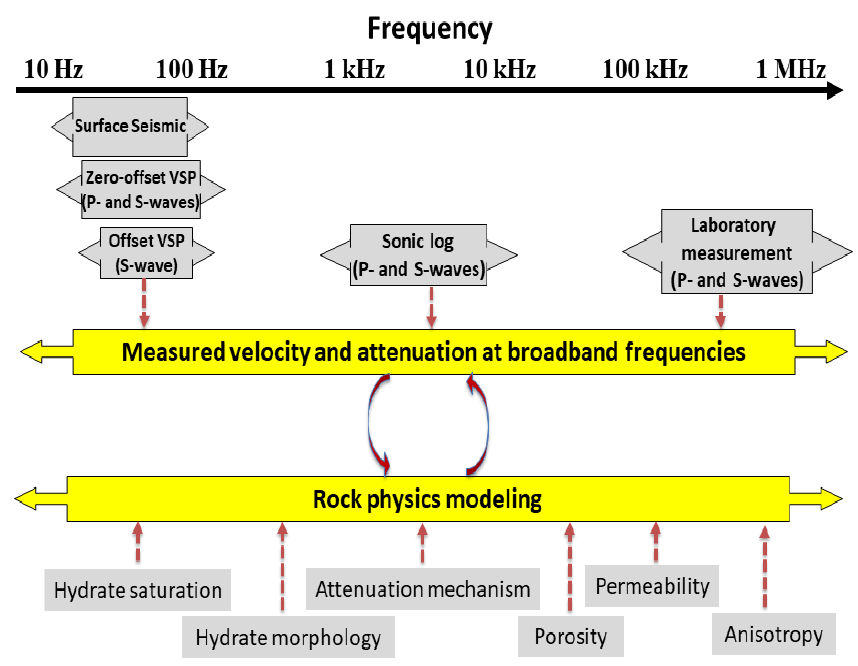
Figure 3. The frequency-dependent velocity and attenuation from field measurements and rock physics modeling.